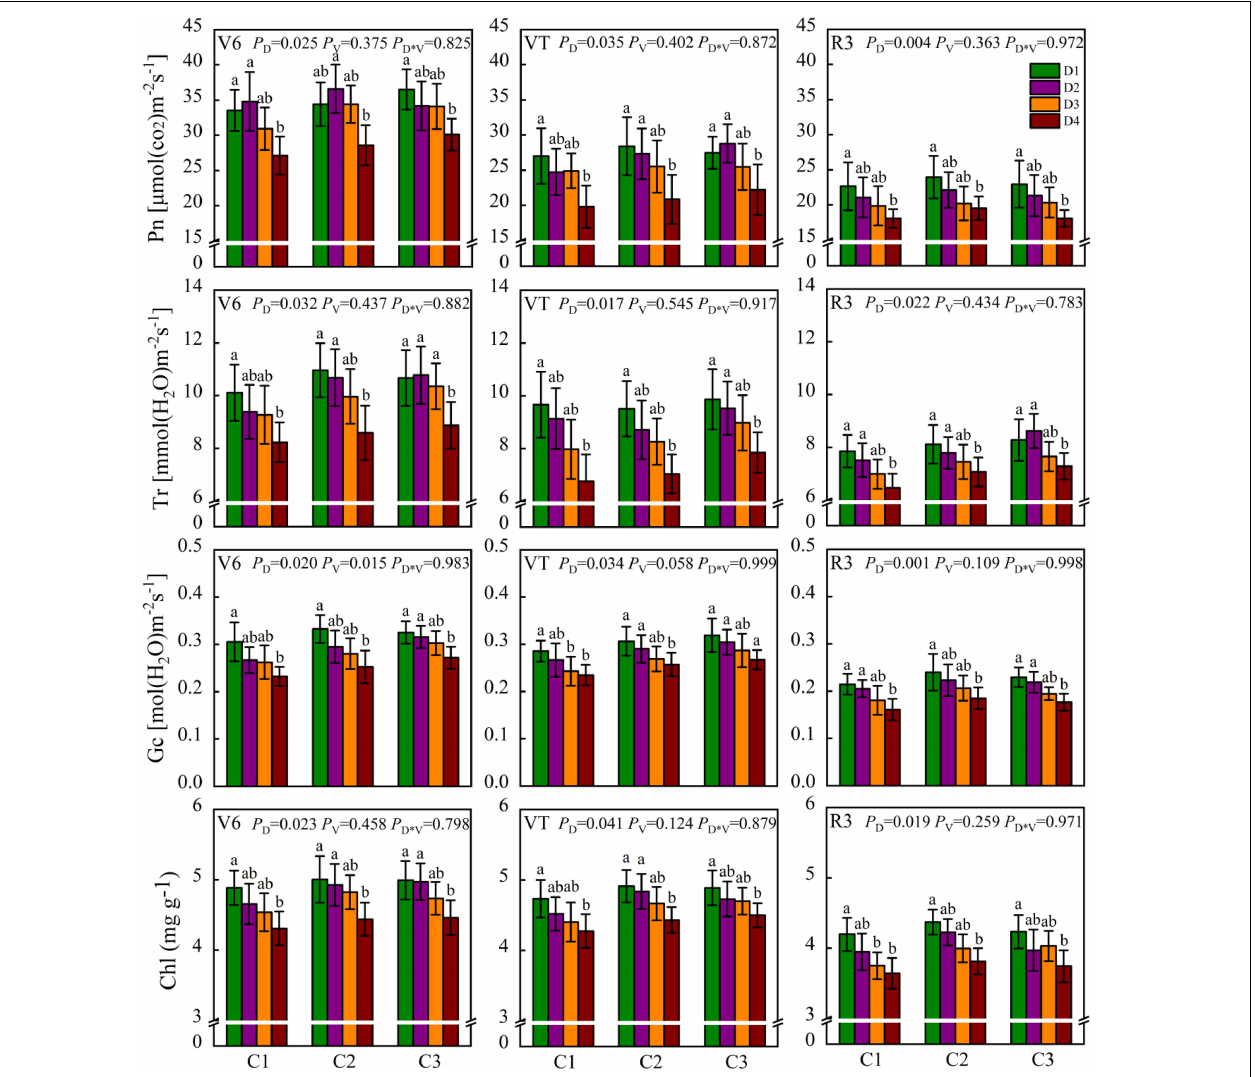
FIGURE 4 | Net photosynthetic rate (Pn), transpiration rate (Tr), stomatal conductance (Gc), and leaf chlorophyll content (Chl) of dryland maize under different treatments. D1: 52,500 plants ha − 1 ; D2: 67,500 plants ha − 1 ; D3: 82,500 plants ha − 1 ; D4: 97,500 plants ha − 1 ; C1: Yuyu22; C2: Zhengdan958; C3: Xianyu335. Data represent mean ± SD over six cropping seasons. P -values of the ANOVA of density ( P D ), cultivar ( P V ), and their interaction ( P D ∗ V ) were also